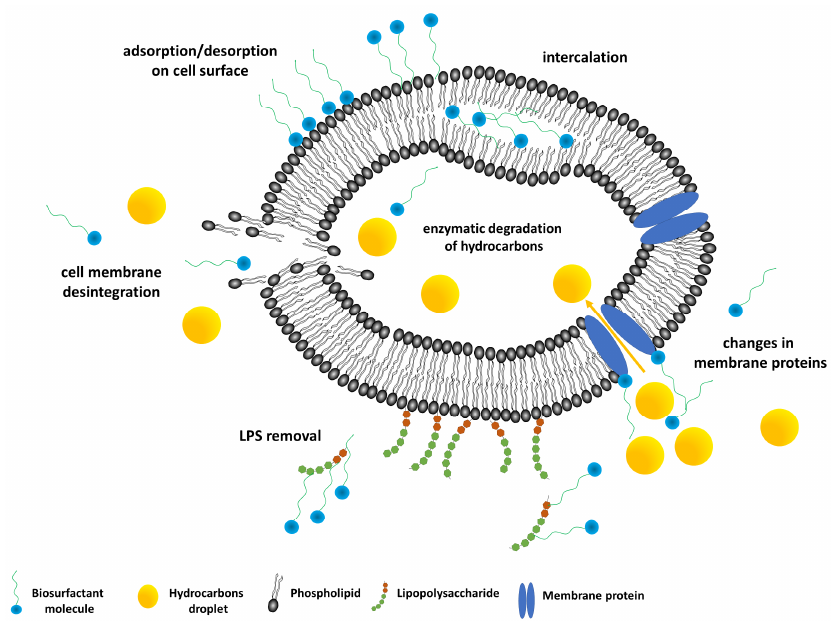
Figure 3. Main interactions between bacteria cells and biosurfactants molecules.